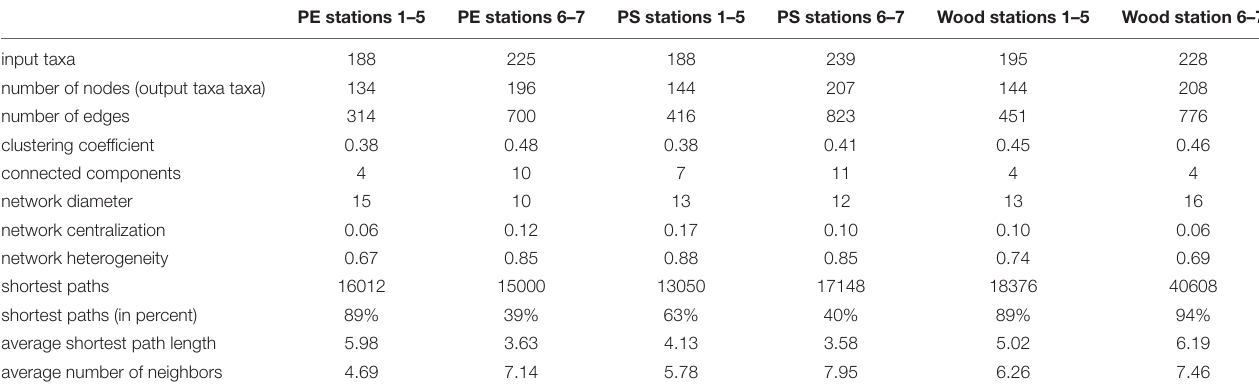
TABLE 1 | Topological parameters of co-occurrence networks for PE, PS, and wood from both incubation experiments I (Baltic Sea to River Warnow, stations 1 to 5) and II (WWTP, stations 6 and